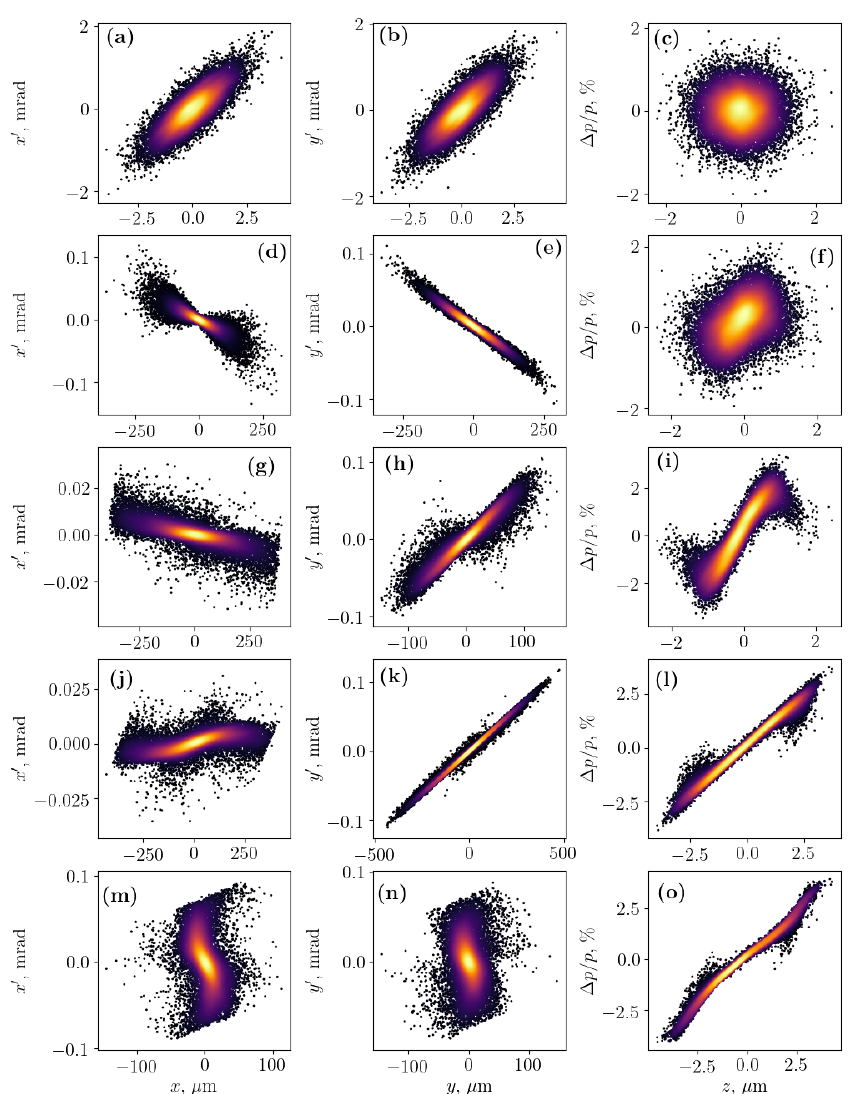
Figure 4. Simulated transverse and longitudinal phase space projections after each beamline sec- tion: after the source ( a – c ), after the capture block ( d – f ), after the momentum filter ( g – i ), after the decompressor ( j – l ) and in the middle of the undulator ( m – o